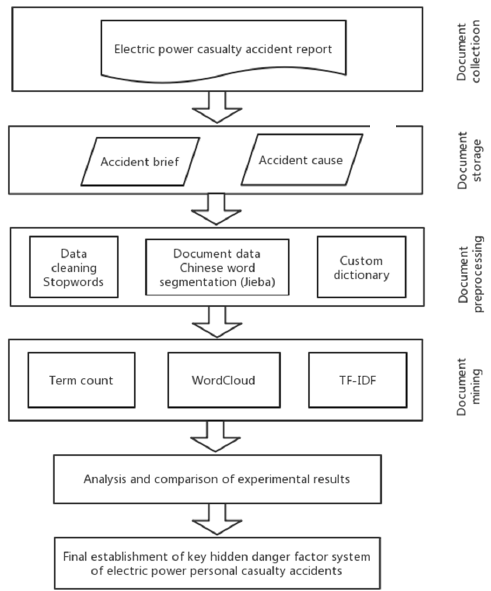
Figure 1. Document mining of electric power personal casualty accident